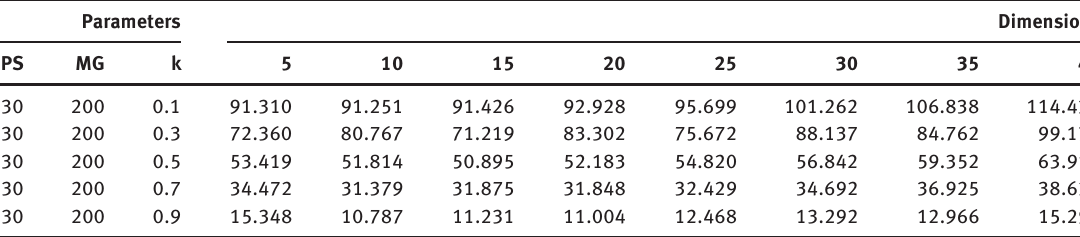
Table 2. Mean Optimization Results on Different k .